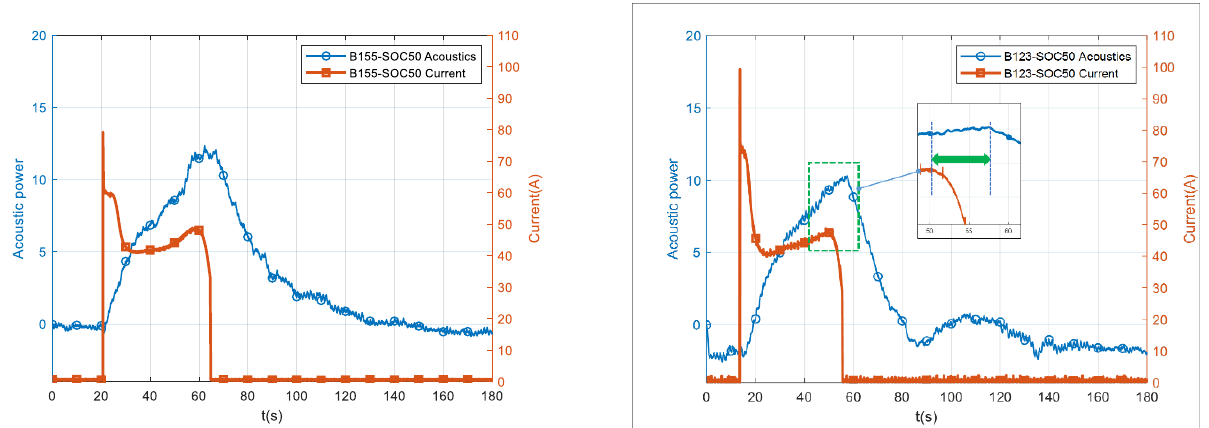
Figure 6. Current and acoustic characteristics of ESC under initial SOC50 condition.